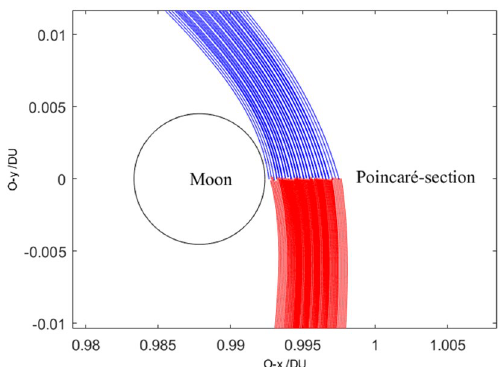
Figure 6. The partial enlarged detail of the Poincaré-section.